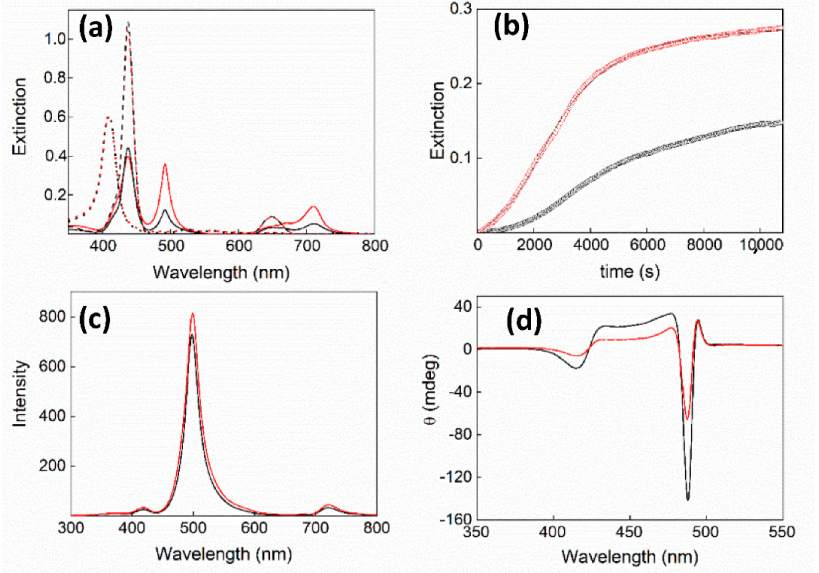
Figure 5. ( a ) Extinction spectra before (dotted line), soon after initial mixing (dashed lines), and at the end of the aggregation (solid lines), ( b ) kinetic extinction time traces at λ = 492 nm (solid lines show the best fit of the experimental data according to Equation (1)), ( c ) RLS, and ( d ) CD spectra for the supramolecular assembling of H 2 TPPS 44 − induced by salt and tartrate buffer (L: black lines; D: red lines) using mix 2 protocol. Experimental conditions: [H 2 TPPS 44 − ] = 3 µ M; [NaCl] = 1.5 M; tartrate buffer 100 mM, pH 2.7, T = 298 K.